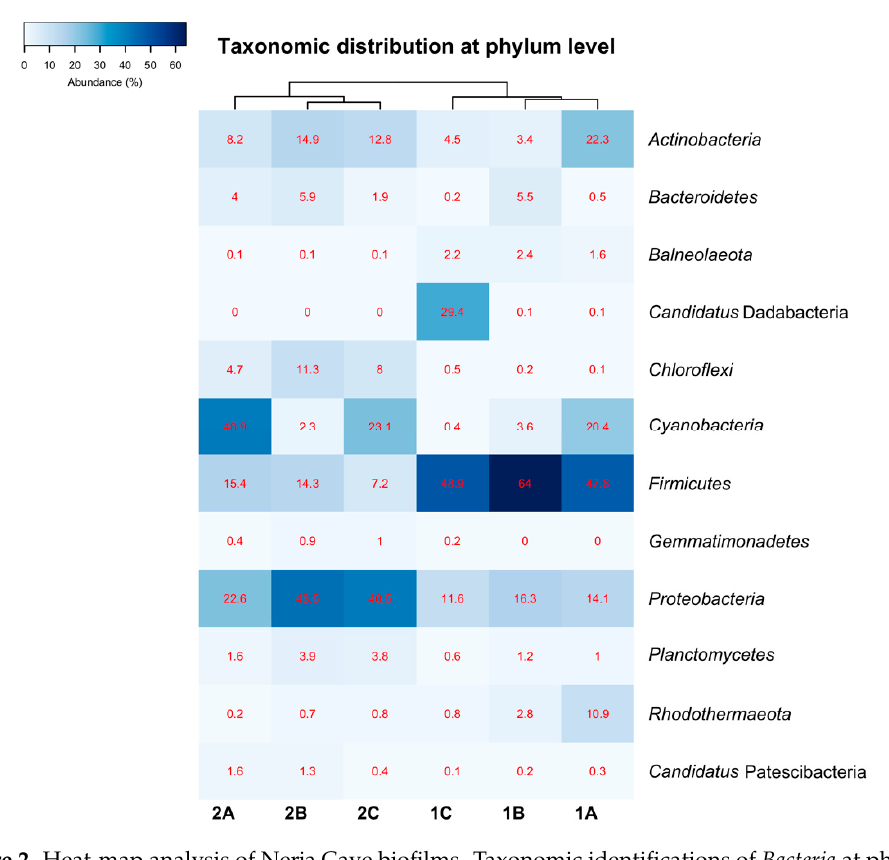
Table 1. Kingdoms distribution in phototrophic biofilms from Nerja Cave.